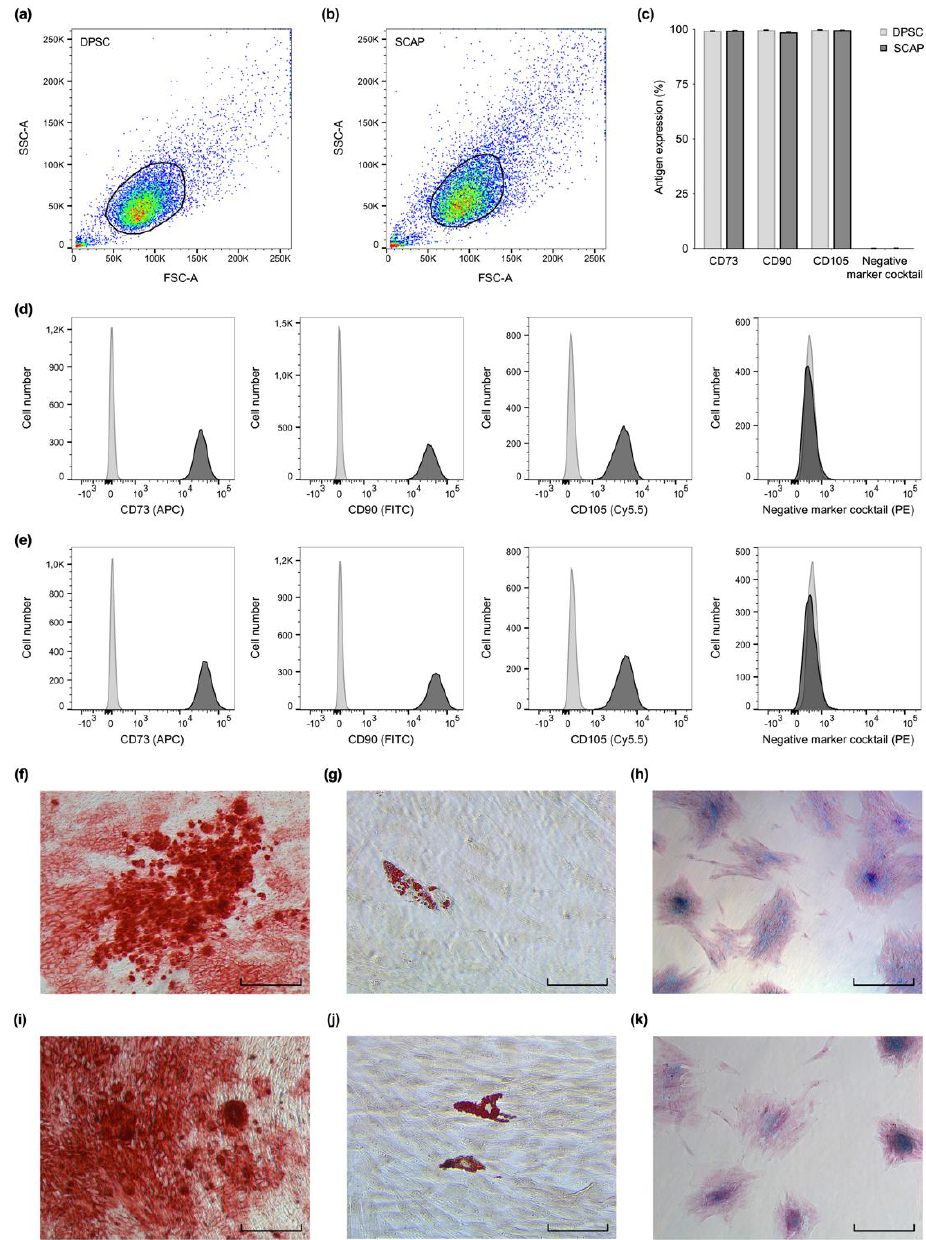
Figure 1. Stem cell characterization. Flow cytometric analysis ( a – e ) revealed similarities in size and granularity for dental pulp stem cells (DPSC) ( a ) and stem cells from the apical papilla (SCAP) ( b ). ( c ) DPSC and SCAP both expressed characteristic mesenchymal stem cell markers (CD73, CD90, and CD105), however, the markers CD34, CD45, CD11b, CD19, and HLA-DR were not detected. Exemplary overlay histograms of DPSC ( d ) and SCAP ( e ) show the control populations (light grey) and the specifically stained cells (dark grey). DPSC ( f – h ) and SCAP ( i – k ) both successfully entered the osteogenic ( f , i ), adipogenic ( g , j ), and chondrogenic lineage ( h , k ). Scale bars: 80 µm.